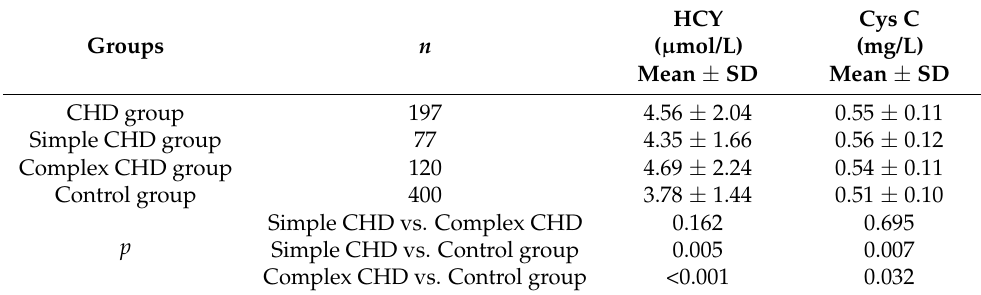
Table 4. Comparison of HCY and Cys C levels at 12–14 weeks of pregnancy.